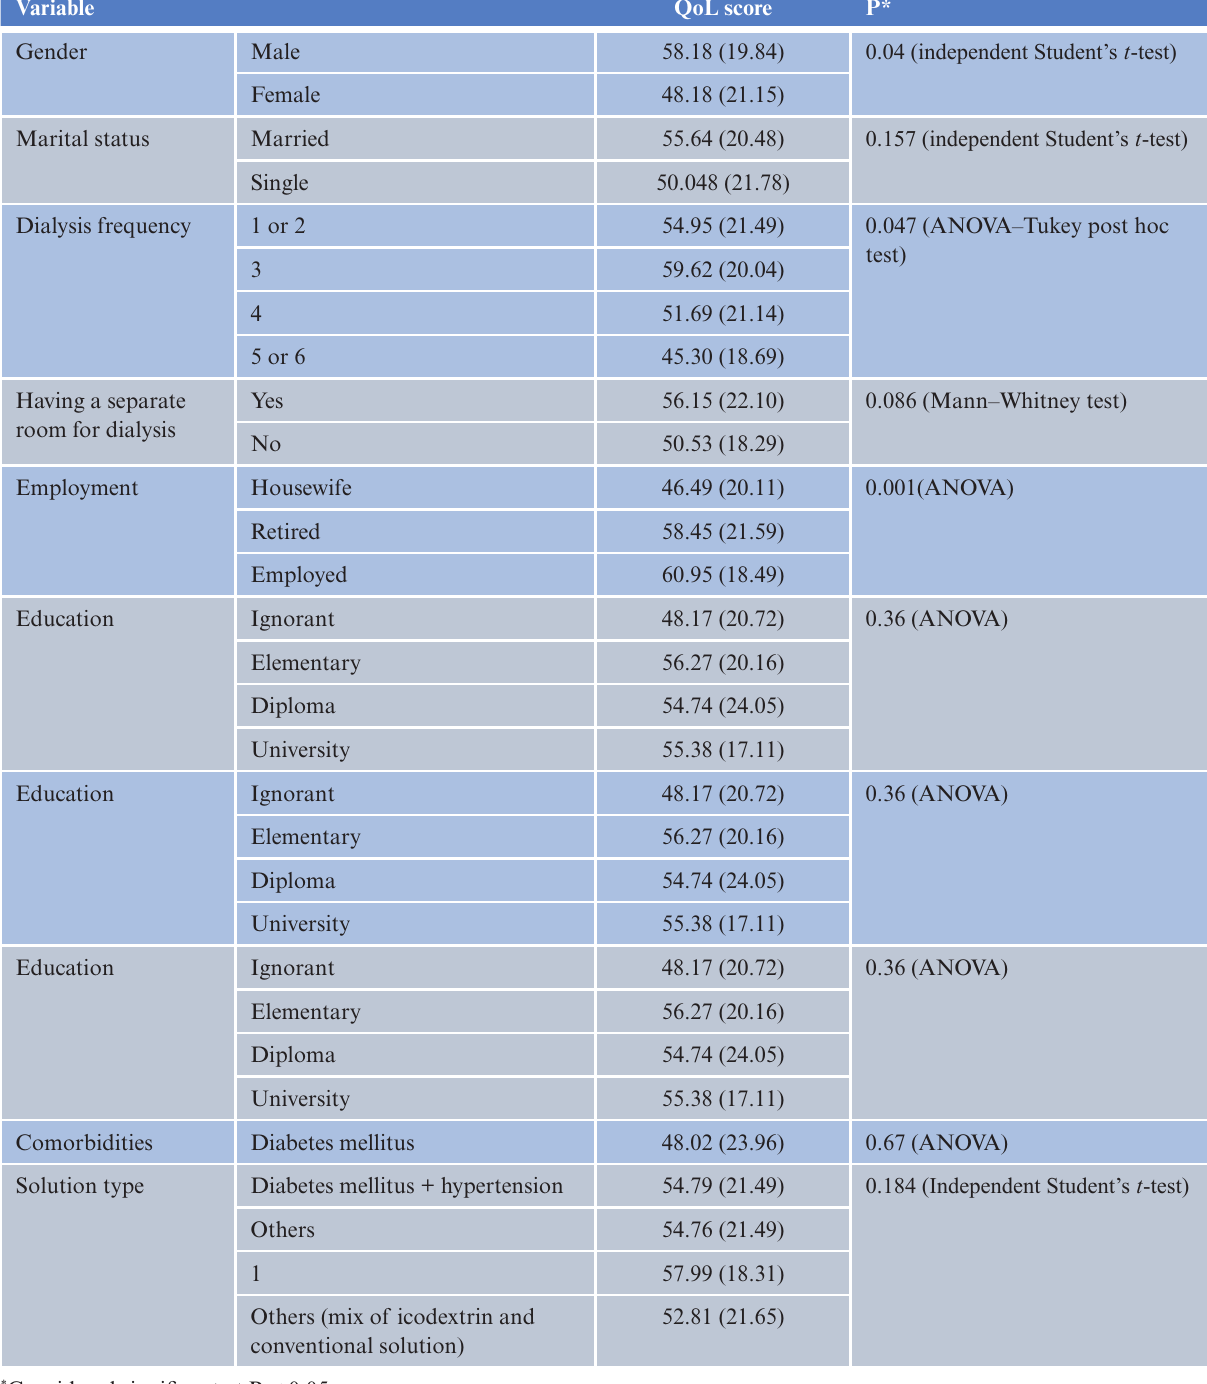
Table 2. Difference in quality of life according to their contributing